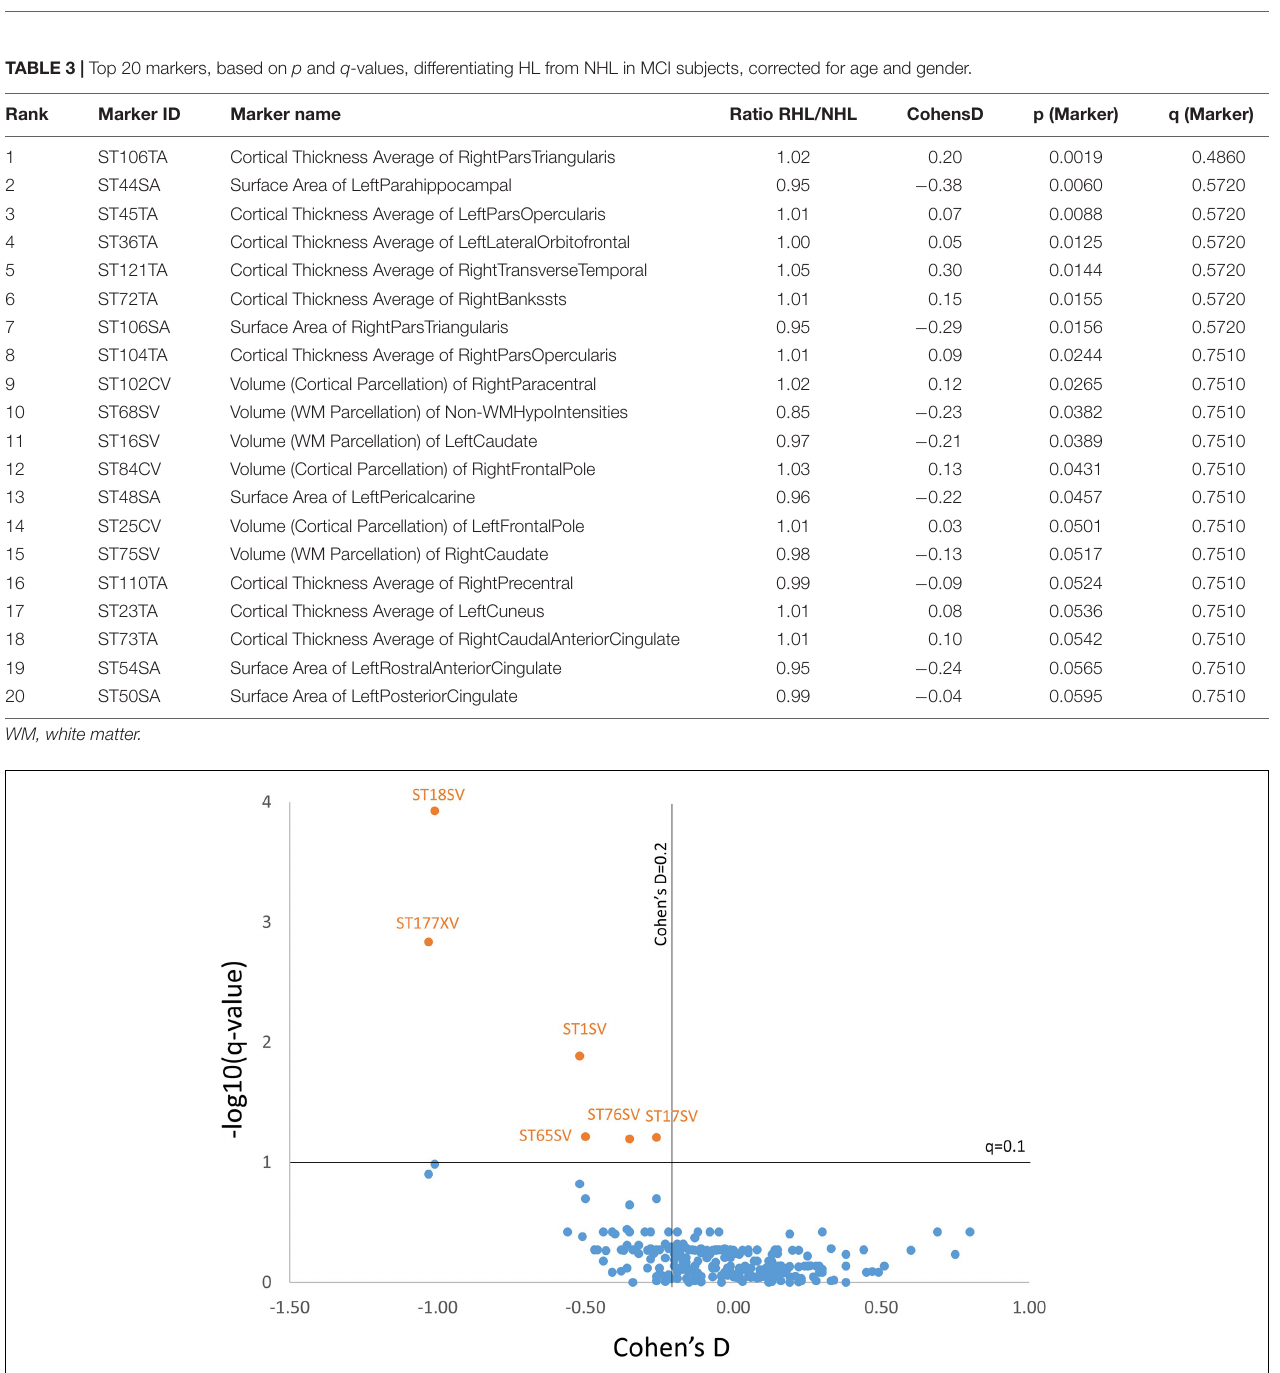
FIGURE 1 | Volcano plot showing the Cohen’s D value vs. –log10( q -value) for all markers for AD subjects. Six markers met criteria for having a q -value of less than 0.1 (–log10( q -value) > 1) and having a Cohen’s D of above 0.2. Marker codes are shown. Full marker names can be found in Table 4 .